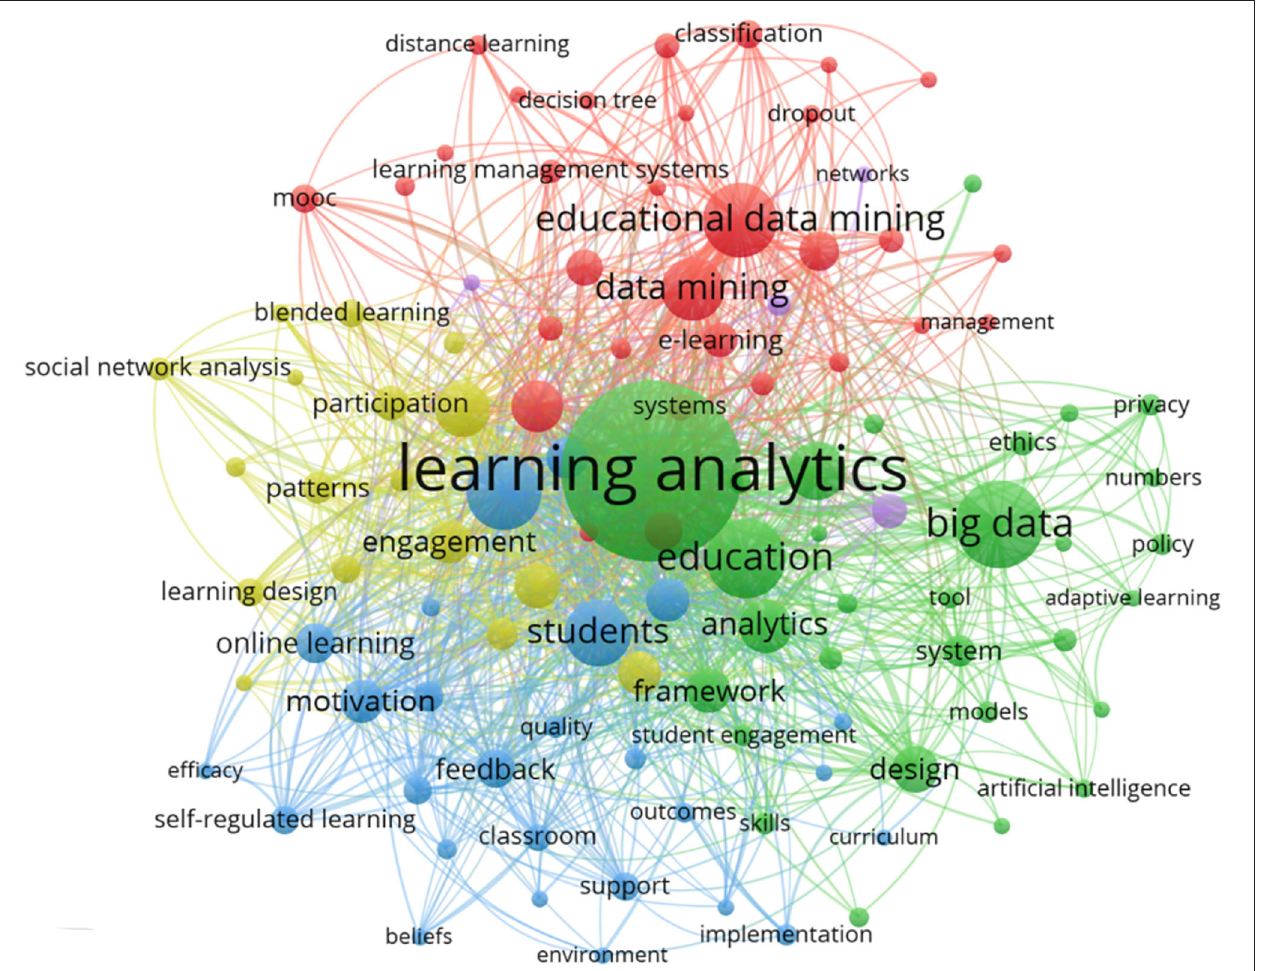
FIGURE 5 | Keywords network visualization of big data in education.